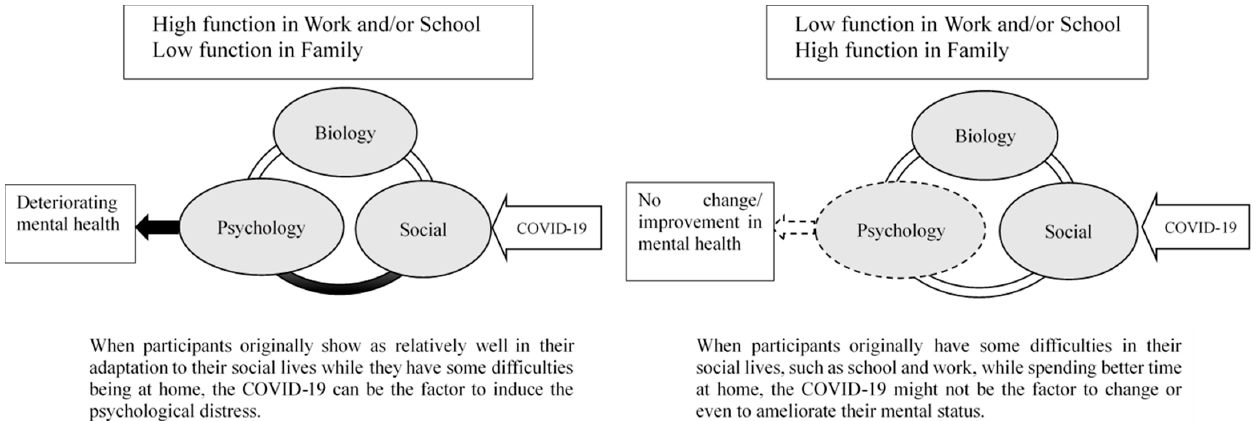
Figure 1. Psychosocial effect on ADHD during the